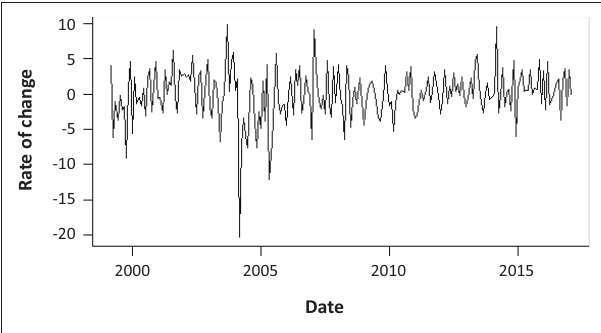
FIGURE 3: South Africa – Movement of the rate of change in reserves-to-M1 ratio.